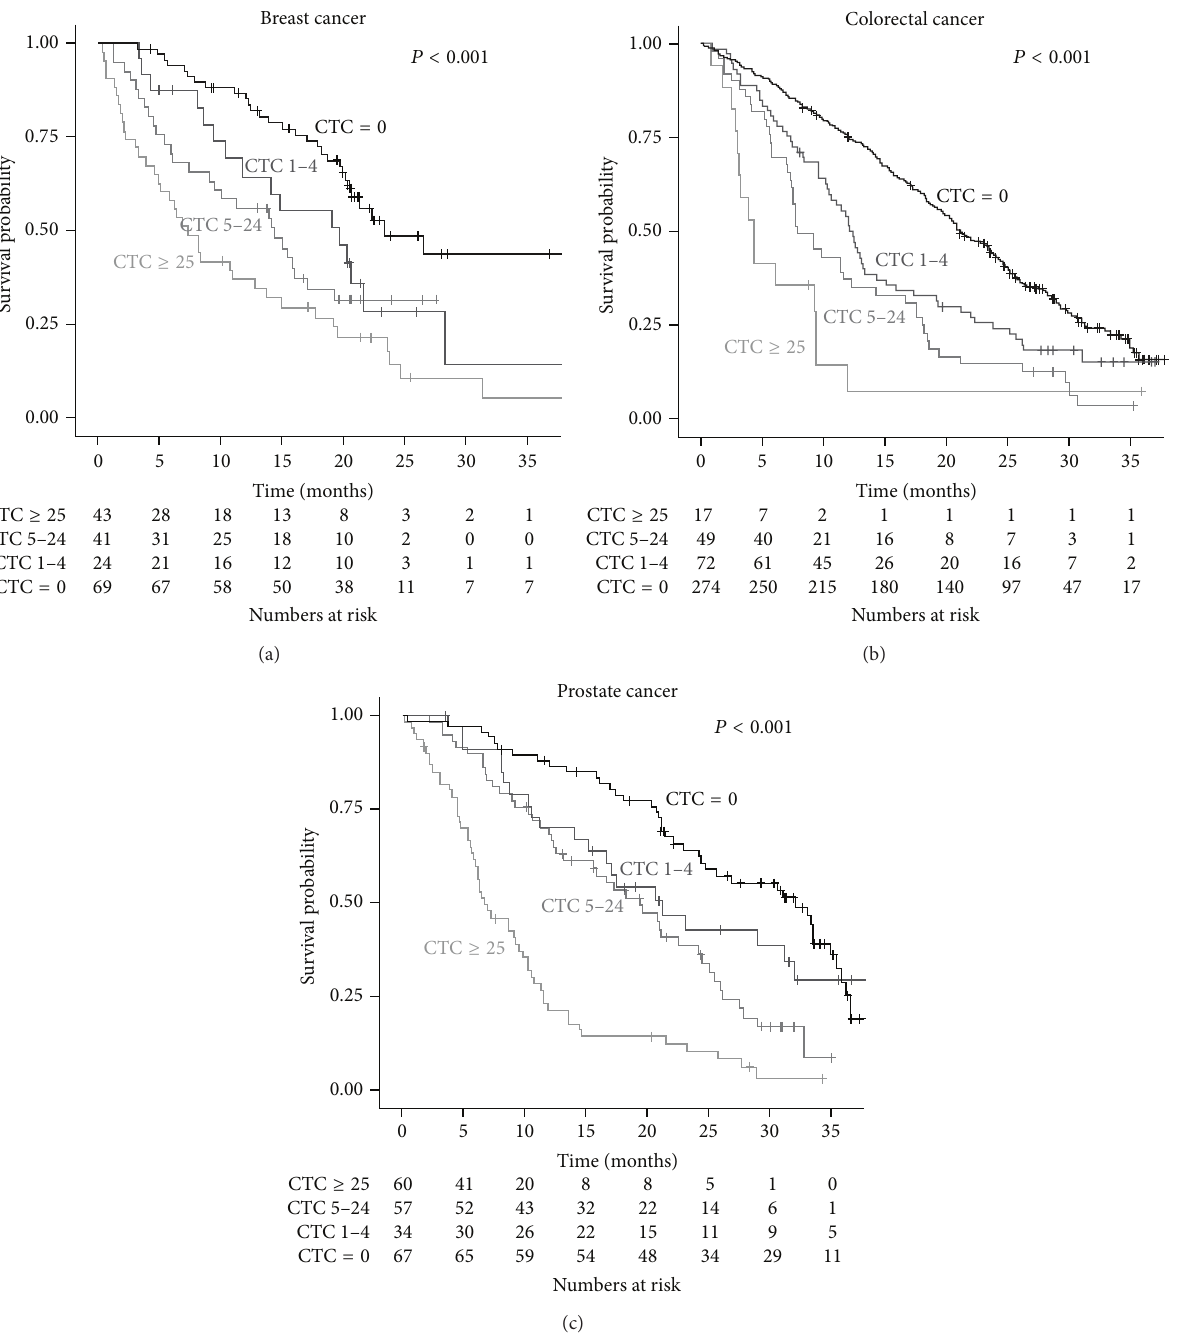
Figure 4: Kaplan-Meier plots of samples from metastatic breast (a), colon (b), and prostate (c) cancer patients with 0, 1–4, 5–24, and > 25 CTC at the start of therapy. The number of patients at risk is listed at every time point of measurement.